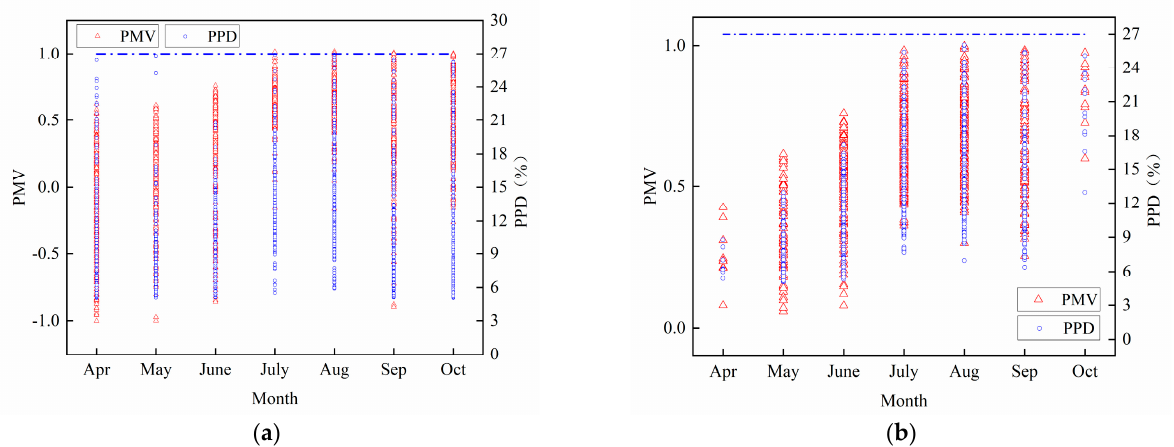
Figure 14. PMV and PPD thermal comfort data for the ( a ) mixed − mode and ( b ) air conditioning mode.